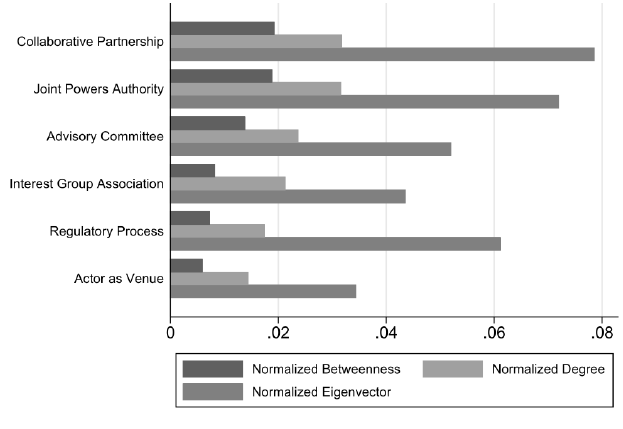
Fig. 6 . Centrality by institution